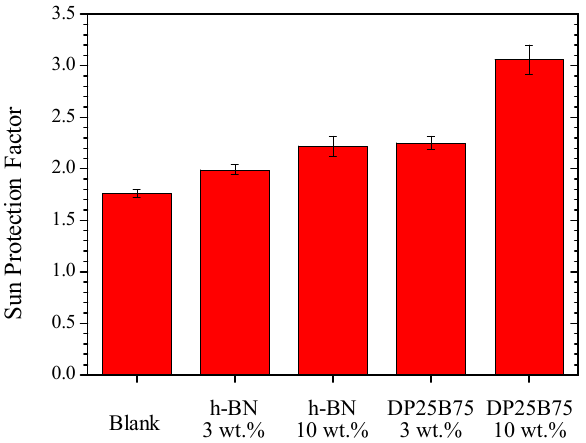
Figure 6. Sun protection factor (SPF) of BB creams with or without h-BN and DP25B75 powder.